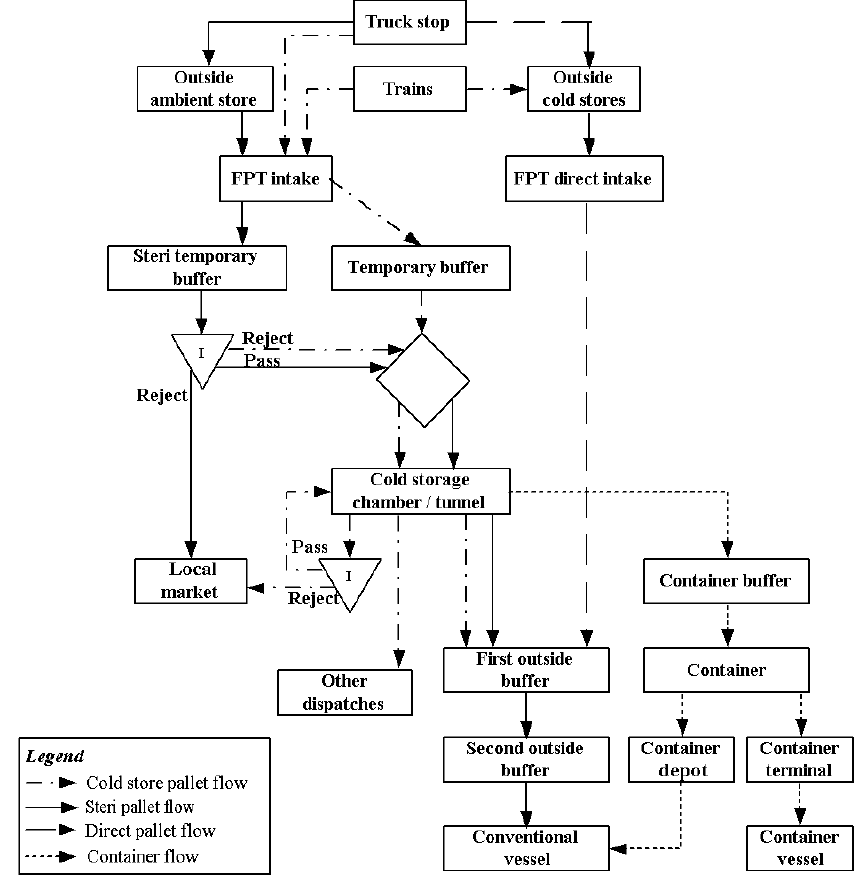
Figure 1: Schematic of pallet movement at